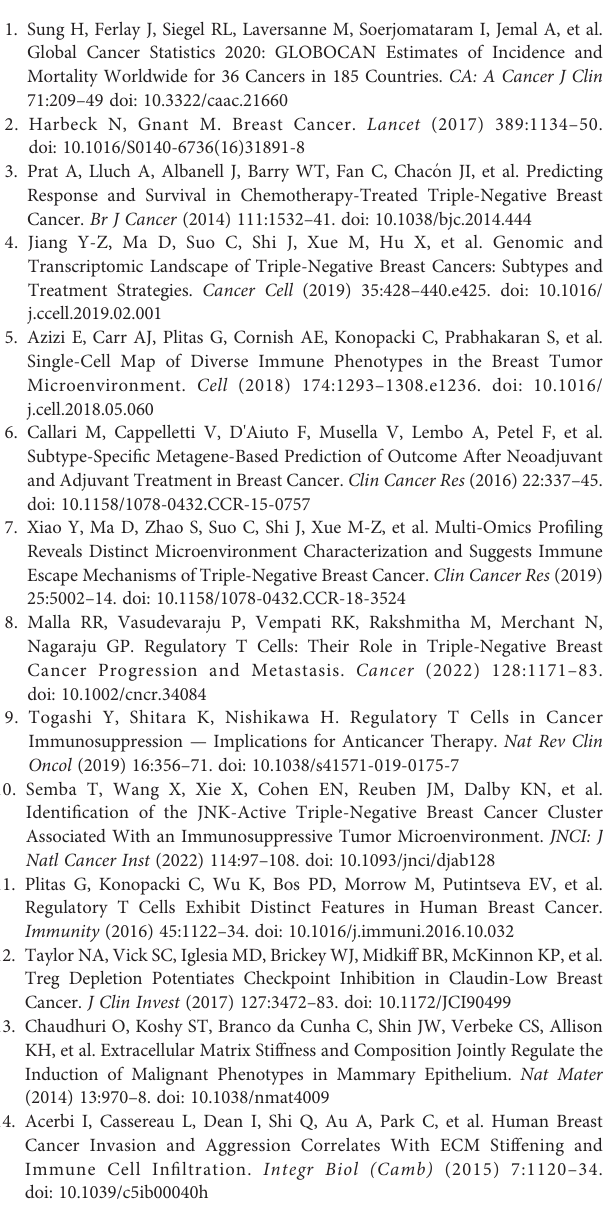
Supplementary Figure 2 | Results of KEGG analyses between different Treg expression groups.